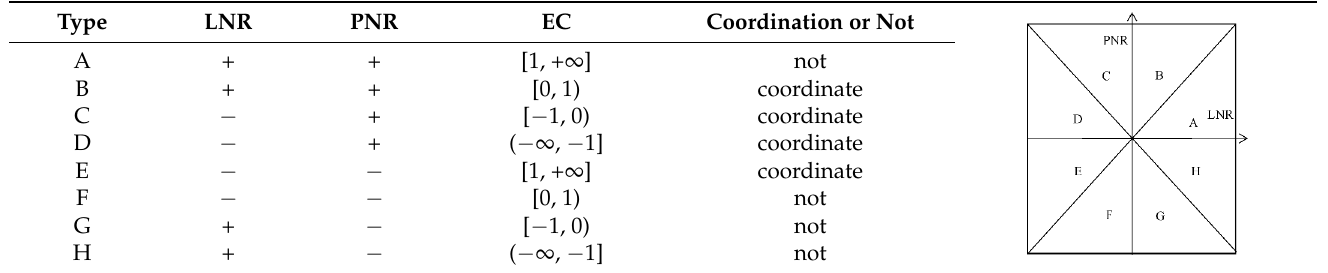
Table 2. Spatial distribution of some driving factors.